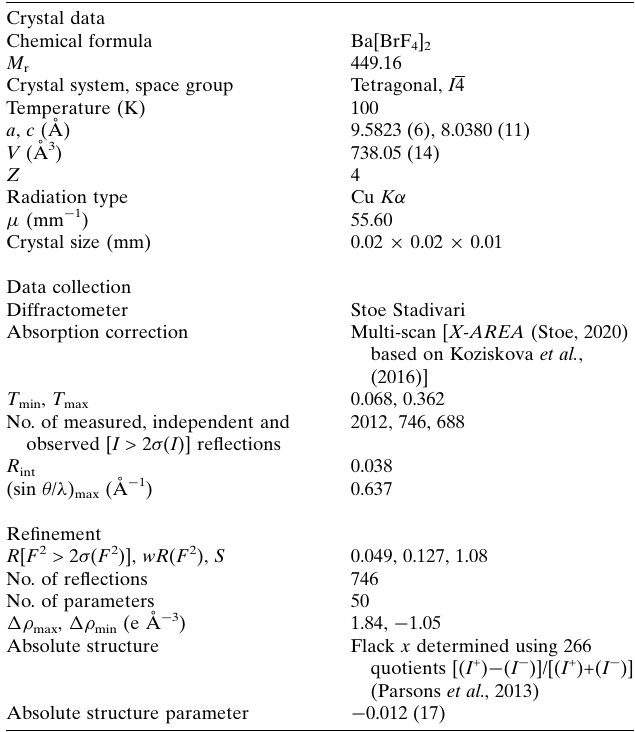
, y + 1 , z + 1 ; (xiv) x + 1 , y (cid:2) 1 , z + 1 2 2 2 2 2 2